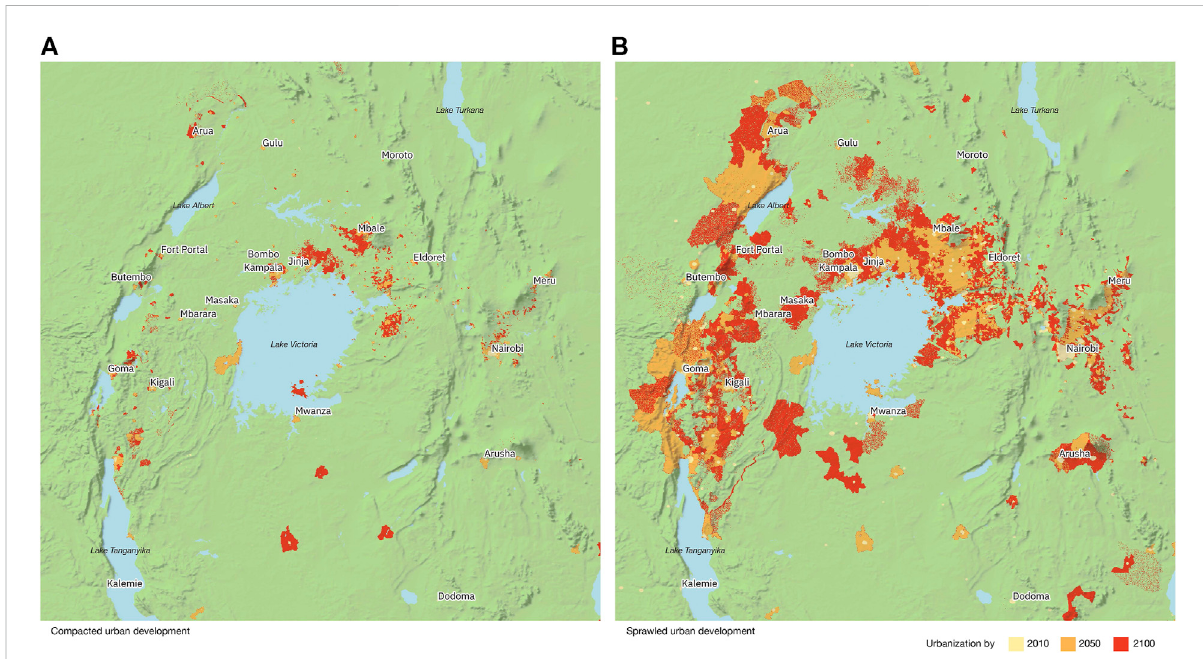
FIGURE 1 Image ofthe two different urban growth simulation outputsfor the Lake Victoria Region, Africa. The fi gure incorporates SSP4 urban population growth across the region for the compact (A) and sprawled (B) urban growth models. Highlighted are the results of simulations runs for the years 2010, 2050 and 2,100. The image demonstrates the signi fi cant urban land use differences between the two